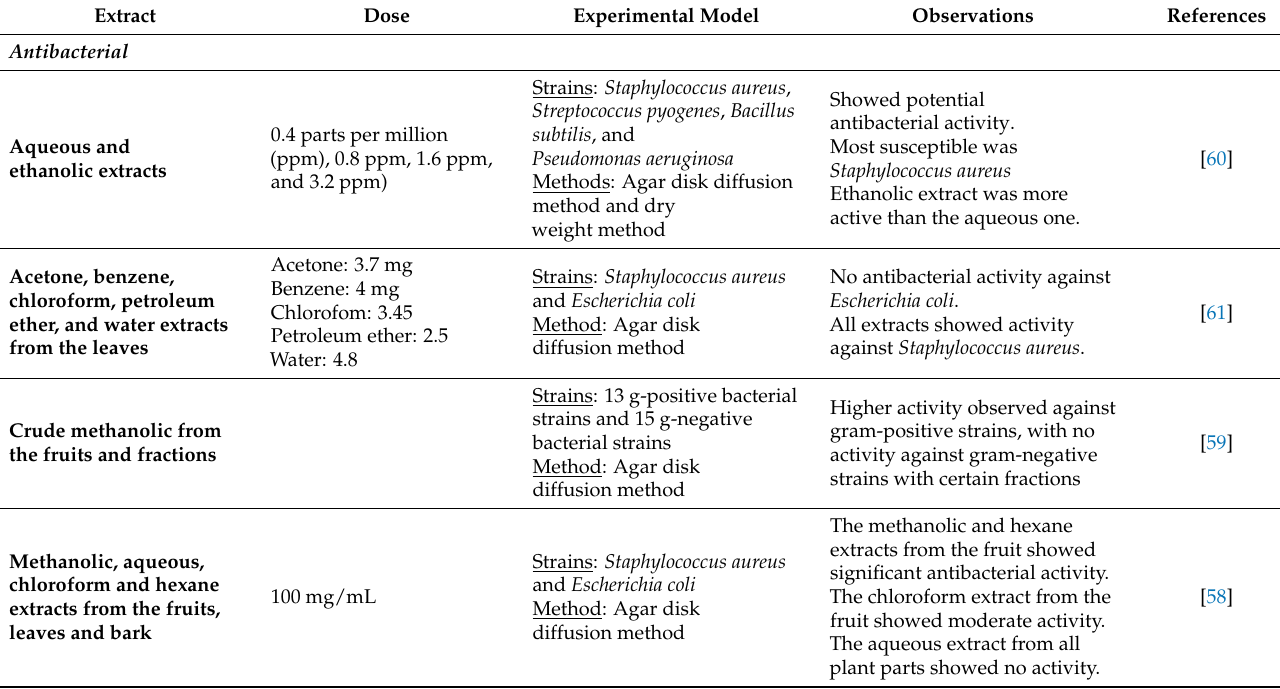
Table 3. The antimicrobial effects of Zizphus nummularia